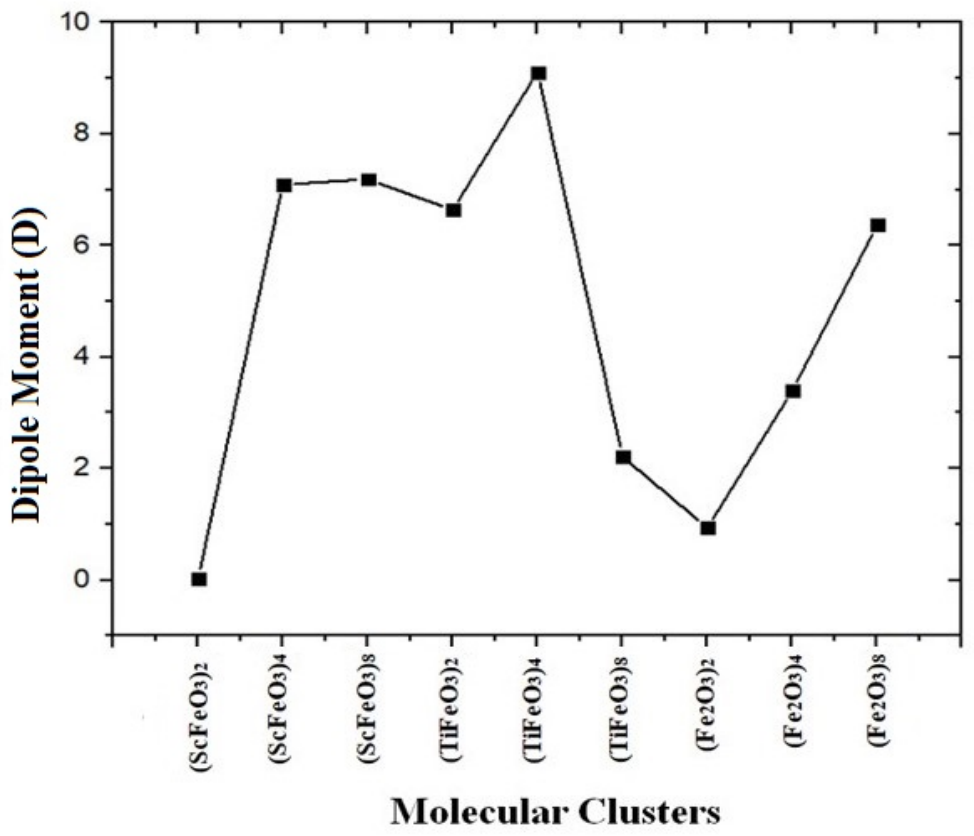
Figure 3. The calculated values of dipole moment (D) for [(TMFeO 3 )] x molecular clusters for x = 2, 4, 8 and TM = Sc, Ti, Fe.